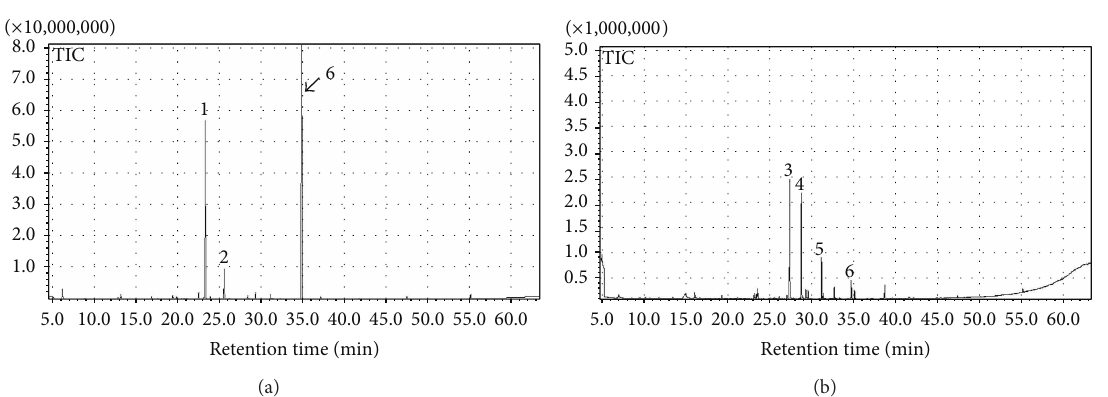
Figure 3: SPME-GC/MS traces of volatile fraction of black locust petals (a) and nectar (b). (1) Z-Ocimene ; (2) geranyl nitrile ; (3) hexanol ; (4) allo-ocimene ; (5) cis-linalool-oxide ; (6) linalool .